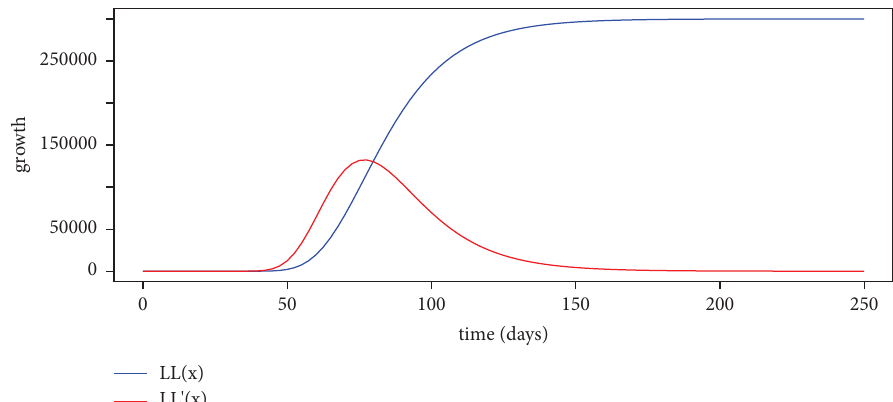
Figure 5: Log-logistic curve with fnal level of 300,000. Te red line shows the corresponding change curve multiplied by 10.